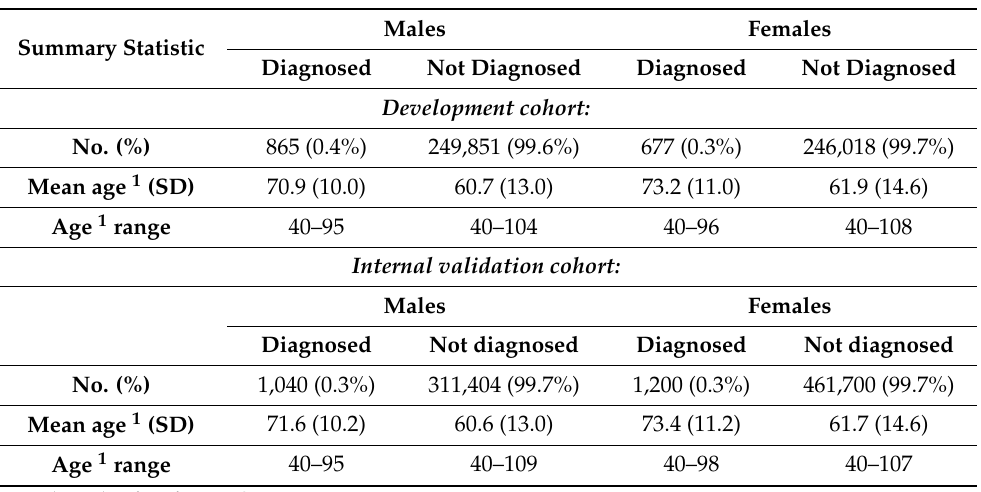
Table 1. Summary of patient characteristics.